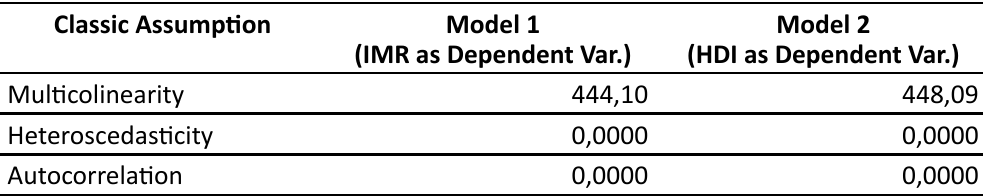
Table 3: FEM Classic Assumption Test